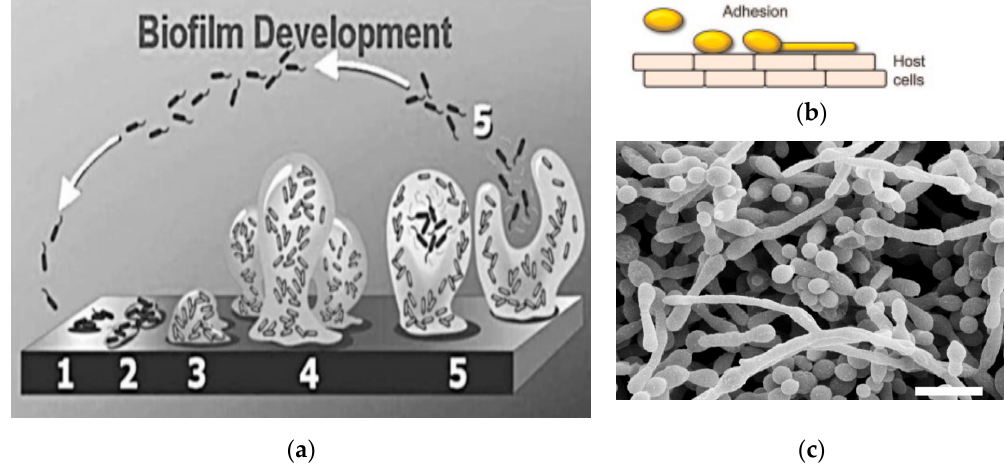
Figure 1. ( a ) The five-stage process involved in the development of biofilm: 1. adherence of yeasts to a surface followed by yeast-to-hyphal transition; 2. the exopolymeric matrix (EPM) is produced resulting in a firmly adhered “irreversible” attachment; 3. early biofilm architecture is developed; 4. the biofilm reaches maturation in a three-dimensional structure and 5. single planktonic cells are dispersed from the mature biofilm. Reproduced from Stoodley et al., 2002 [49]. Image credit: D. Davies, with permission of Prof. David Davies. ( b ) A clearer scheme of stage 1. Yeasts adhere to host cell surfaces. Contact to host cells triggers the yeast-to-hyphal transition and directed growth via thigmotropism. Reproduced from part of Figure 1a from Mayer et al. [51], with permission. ( c ) A scan electron microscopy (SEM) image of a mature (48 h) Candida albicans biofilm (formed in stage 4 of Figure 1a). Bar = 10 µ m. Yeasts, hyphae, and pseudohyphae can be observed. Most EPM was lost during the SEM procedures. Reproduced from Ramage et al. [50] with